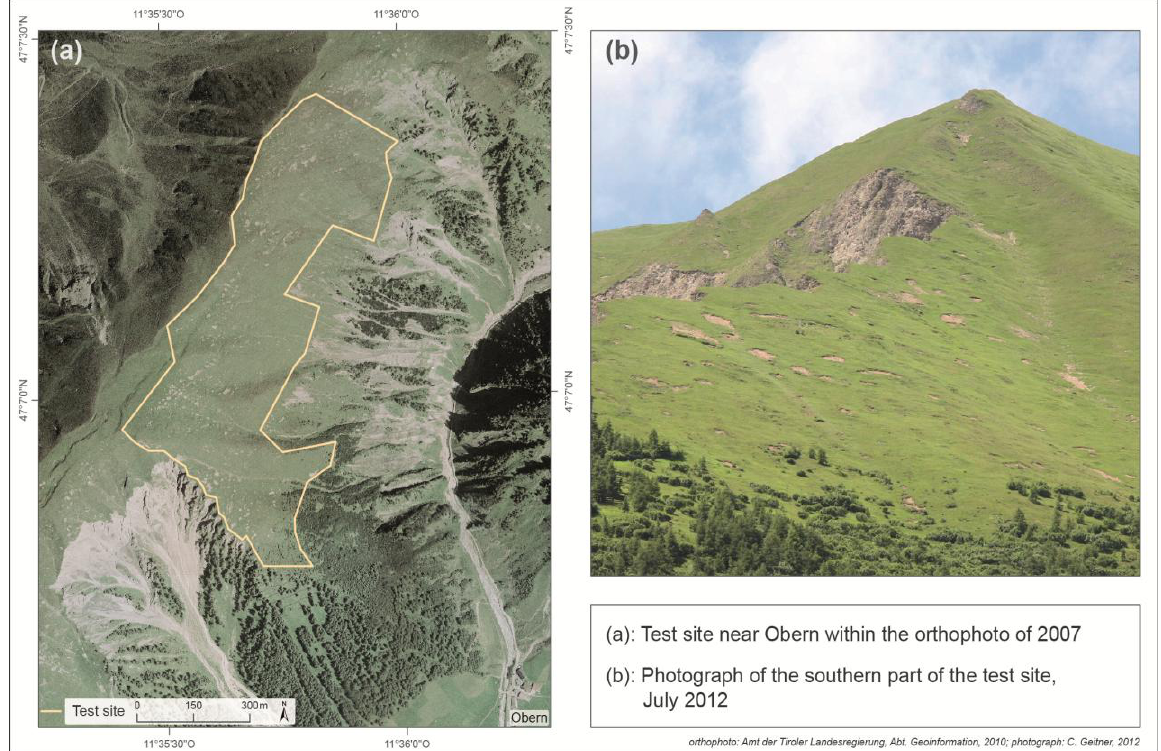
Figure 2. Test site near Obern in the inner Schmirn Valley. ( a ) Test site within the orthophoto; ( b ) photograph of the southern part of the affected slope.